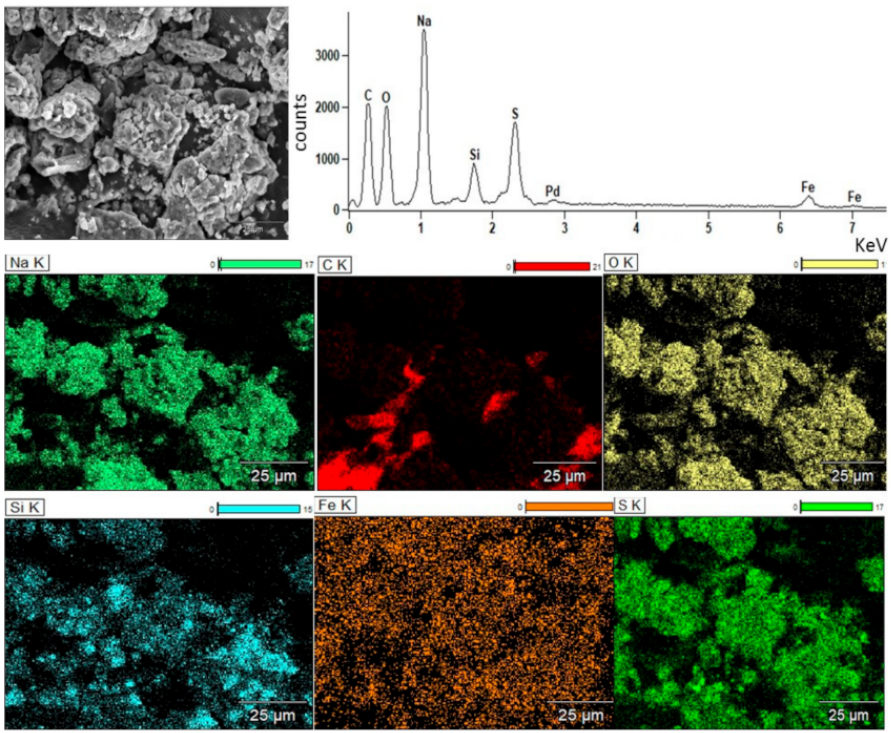
Figure 9. SEM-EDS results for the slag phase obtained for 40 wt.% Na 2 CO 3 and 0.4 g of SiC to 1000 ◦